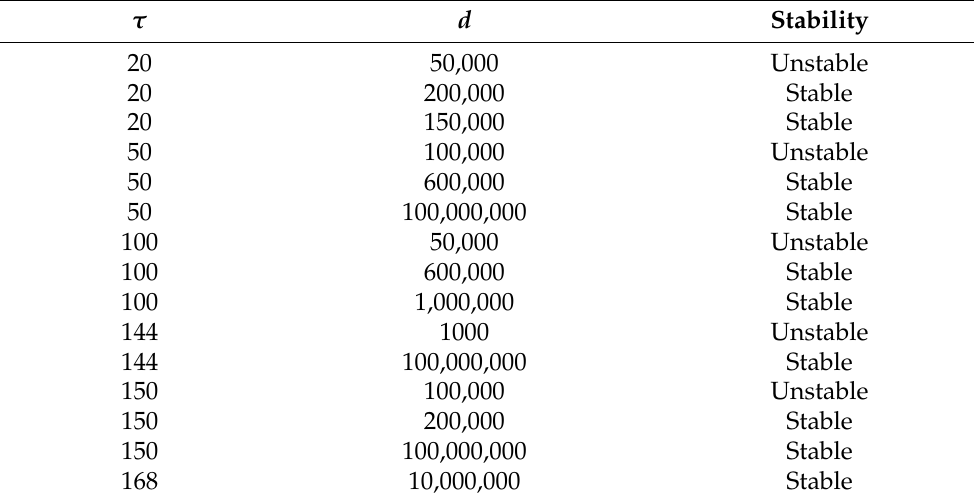
Table 4. Specific numerical results for the stable zone using Equation